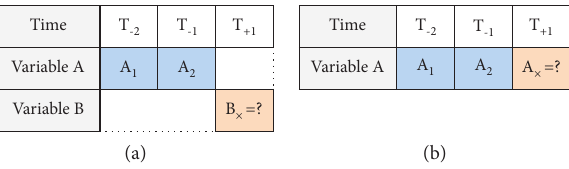
Figure 1: A comparison between exogenous (a) and endogenous (b) forecast variable models. The former aims at predicting a variable ( B from patterns in a precursor variable ( A n ). Conversely, the endogenous variable models try to predict a future state of a variable ( A x ) from its past states ( A n ). Source: own elaboration.